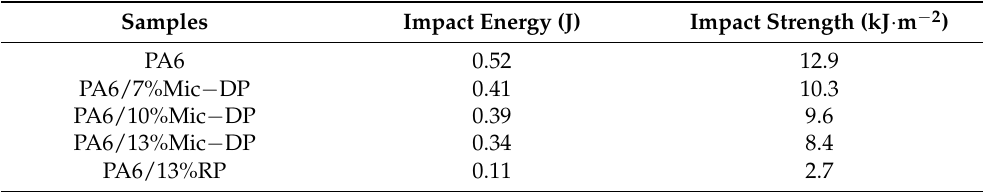
Table 9. Mechanical properties of PA6